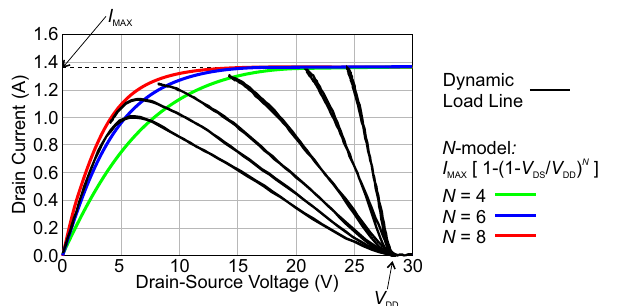
Figure 1. Dynamic load lines (fan diagram) of a GaN HEMT (black lines). The N -model profile is superimposed for different value of N